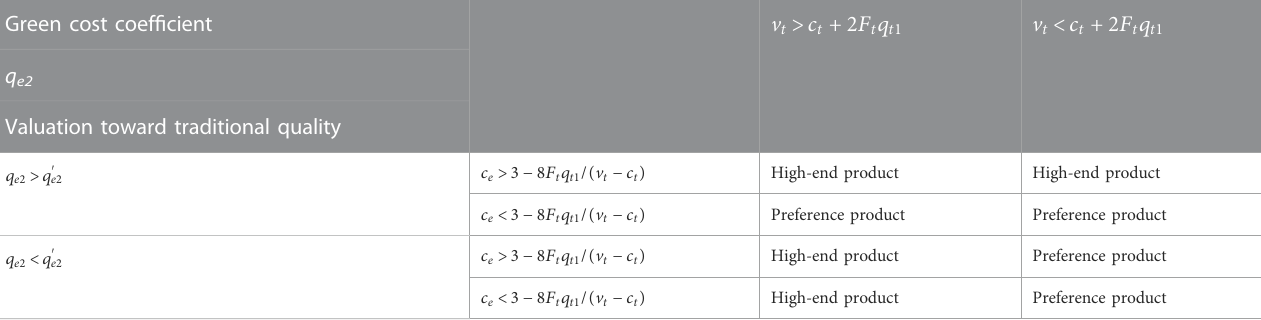
TABLE 3 Product 2 ’ s market positioning by con fi guration of traditional and environmental attributes. Green cost coef fi